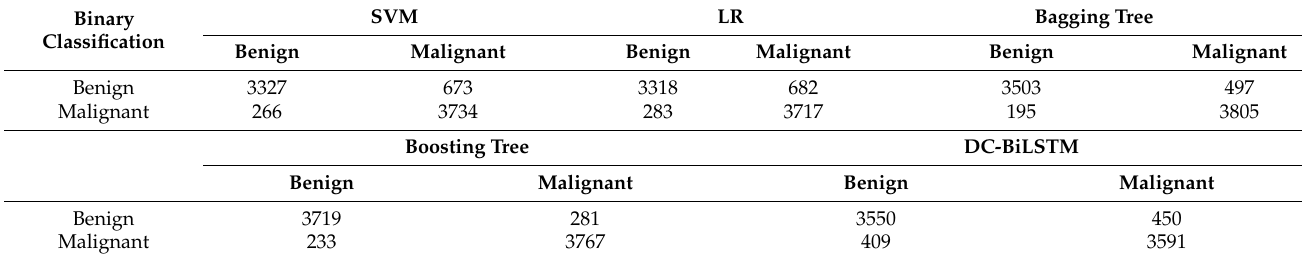
Table 9. Confusion matrices of classification algorithms—Malignant vs. Benign (external test set).